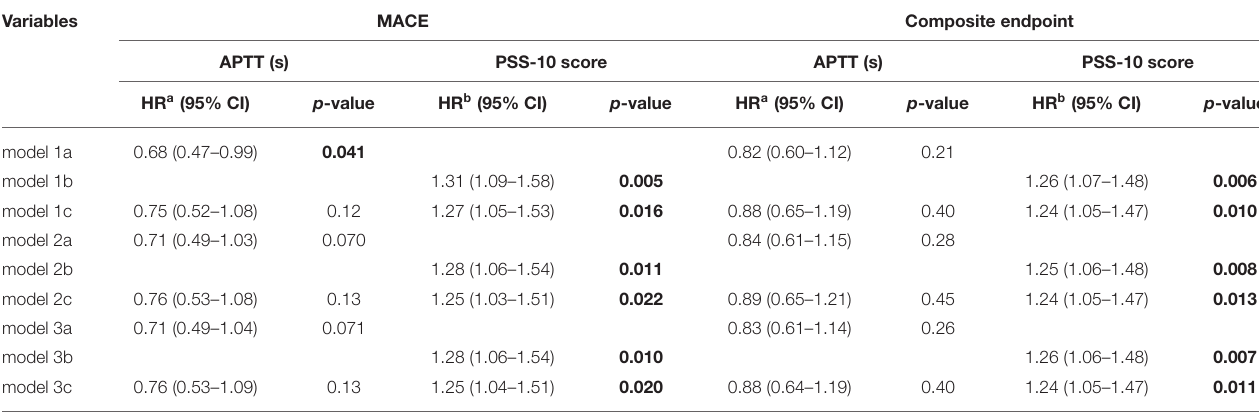
TABLE 5 | Comparison of hazard ratios ( HR s) of APTT, PSS-10, the score for a major adverse cardiovascular event (MACE), and composite endpoint among the different Cox proportional hazard models. Variables